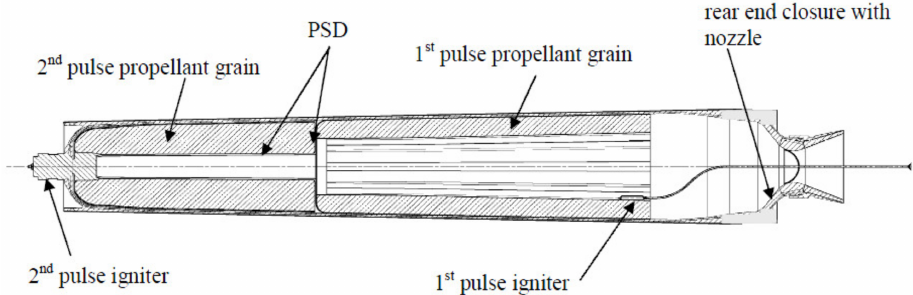
Figure 1. The double-pulse SRM with soft type